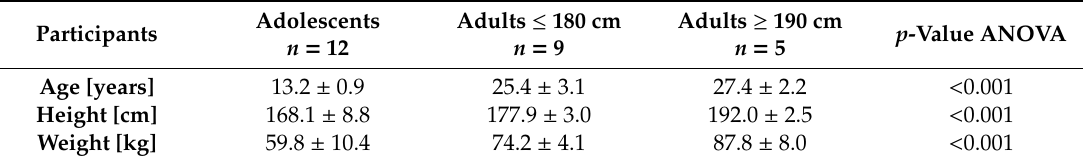
Table 1. Anthropometric di ff erences between the